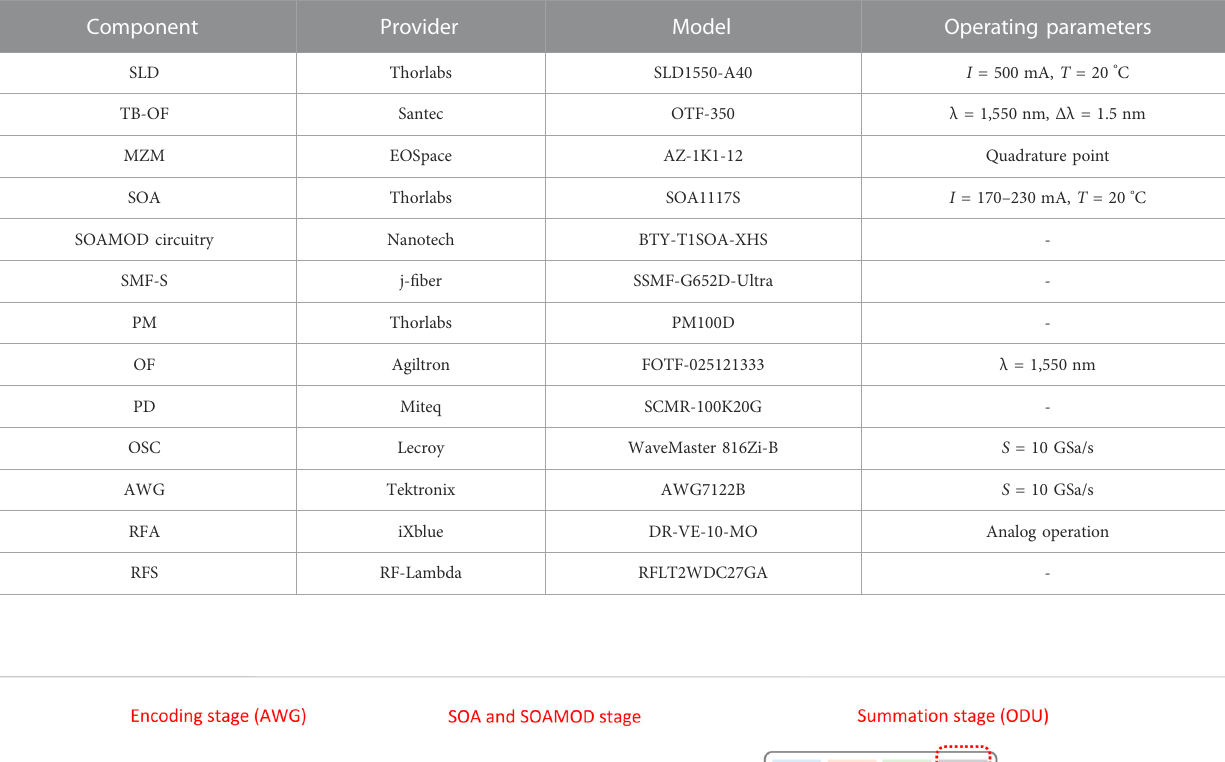
TABLE 1 Components, instrumentation and operational parameters used in the ODU experiment. I : Bias current, T : Temperature, λ : Wavelength, Δ λ : Wavelength bandwidth, S : Sampling rate.